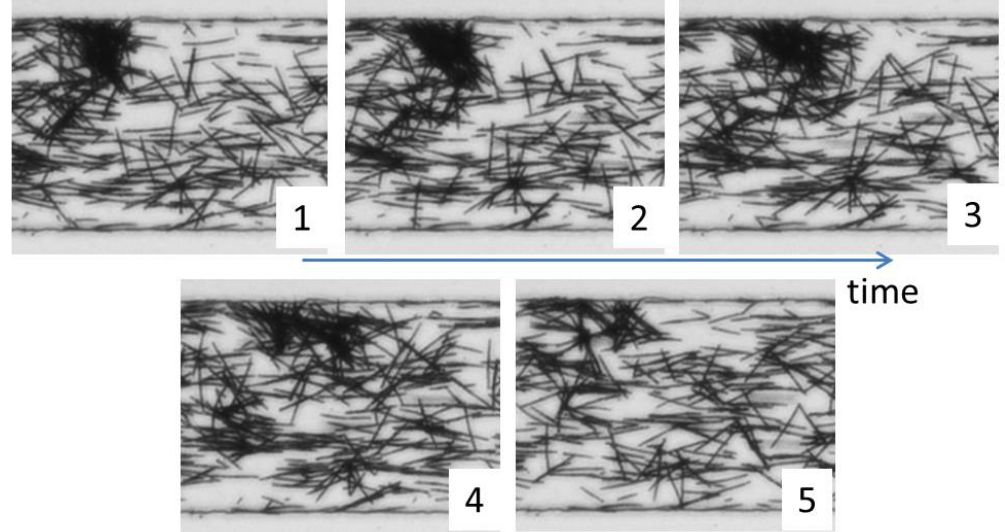
Figure 18. Disaggregation of a fiber cluster caused by incoming fibers. The channel width is 100 µ m. The corresponding video is available in Supplementary Materials Video